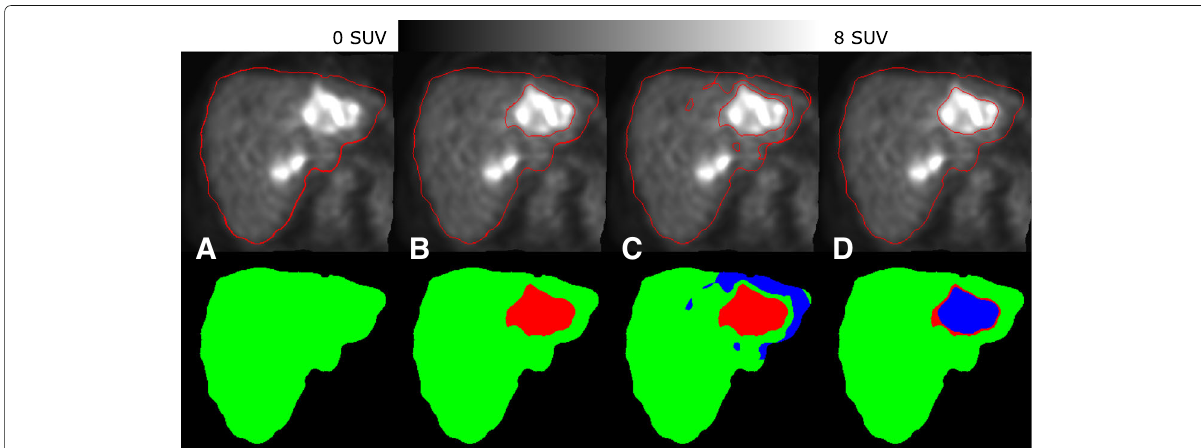
Fig. 4 Tumor segmentation steps for one of the tumors (patient ID BI01 from training set in our database) that is visible in the slice by using the method proposed in [78]. For the other tumor(s), the same algorithm was used a initial 18 F-FDG PET and (liver segmentation: green), b 18 F-FDG initial threshold and finding initial tumor burden (liver segmentation, green ; tumor cores, red), c finding specific background for each tumor (liver segmentation, green; tumor cores, red; background, blue), and d final tumor thresholding (liver segmentation, green; initial tumor volume which is not included in the final tumor segmentation, red; final tumor segmentation, blue)